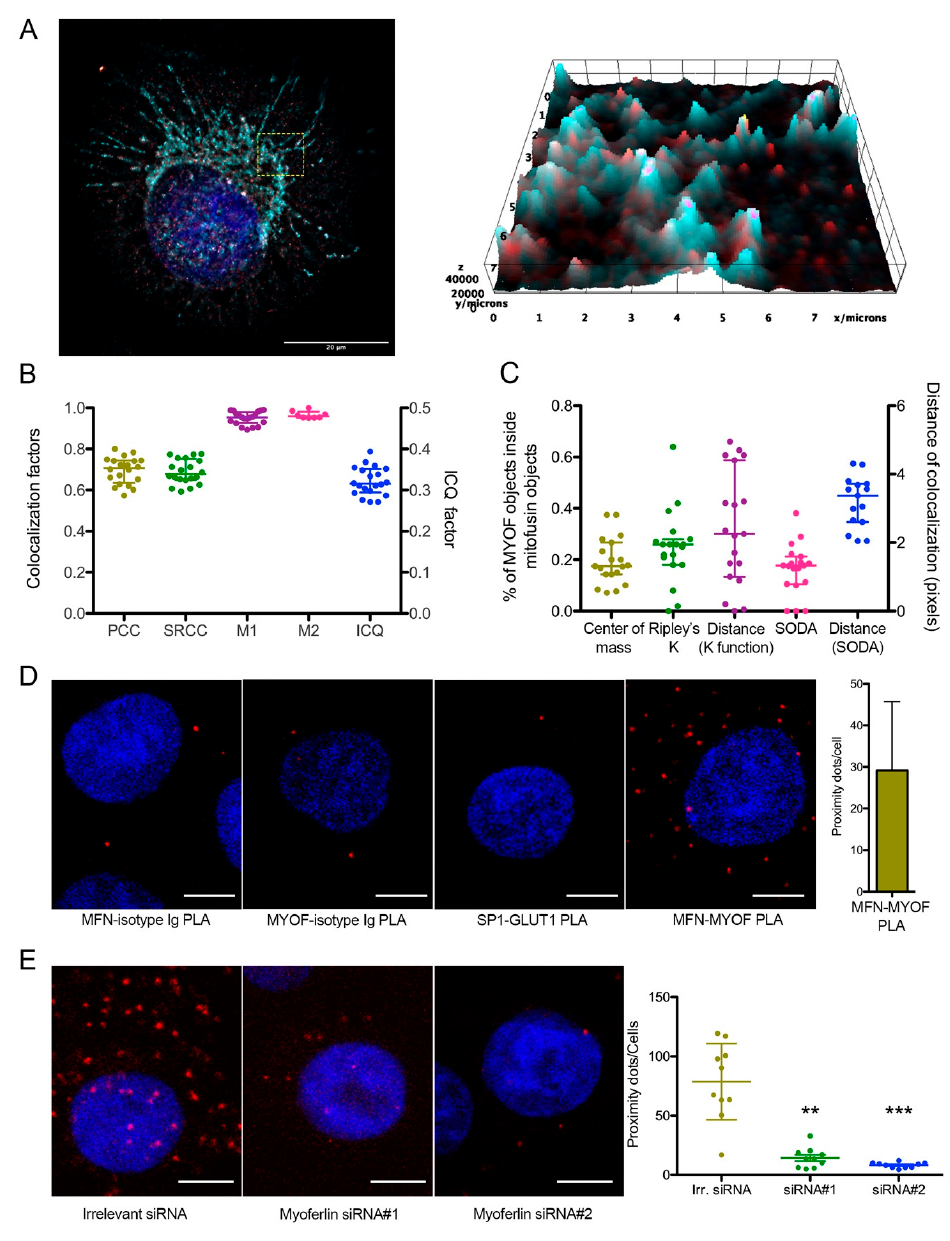
Figure 2. Myoferlin was colocalized with mitochondrial fusion machinery. ( A ) Representative deconvoluted confocal image of nuclei (blue), myoferlin (K16—“hot” red scale) and mitofusin-1 (H65—“cold” cyan scale) immunofluorescence. Scale bar = 20 µ m. Region surrounded by yellow dashed box was used to generate the 2D intensity profile; ( B ) Pearson (PCC), Spearman rank (SRCC) correlation coe ffi cients, Manders’ colocalization coe ffi cients (M1,M2), and intensity correlation quotient (ICQ) were calculated on 20 independent microscopic fields randomly selected; ( C ) percentage of myoferlin-positive objects ( N = 7128) with center of mass overlapping mitochondrial object ( N = 369), percentage of myoferlin-positive object colocalizing mitochondrial object calculated by fitting of the Ripley’s K function or by statistical object distance analysis (SODA). Colocalization distances in pixels were measured in both cases; ( D ) representative images of proximity ligation assay (PLA) between myoferlin (HPA) and mitofusin-1 / 2 (3C9). Scale bar = 4 µ m. Controls were established by substitution of antibodies by control isotypes or by using antibodies against non-interacting proteins (SP1 and GLUT1); ( E ) representative images of PLA in Panc-1 cells transfected with irrelevant or myoferlin-specific siRNA. Scale bar = 4 µ m. MFN1 / 2-MYOF PLA ( N = 10) were quantified using ImageJ. Kruskal–Wallis non-parametric test followed by Dunn’s pairwise comparison was performed, ** p < 0.01, *** p < 0.001. All experiments were performed as three independent biological